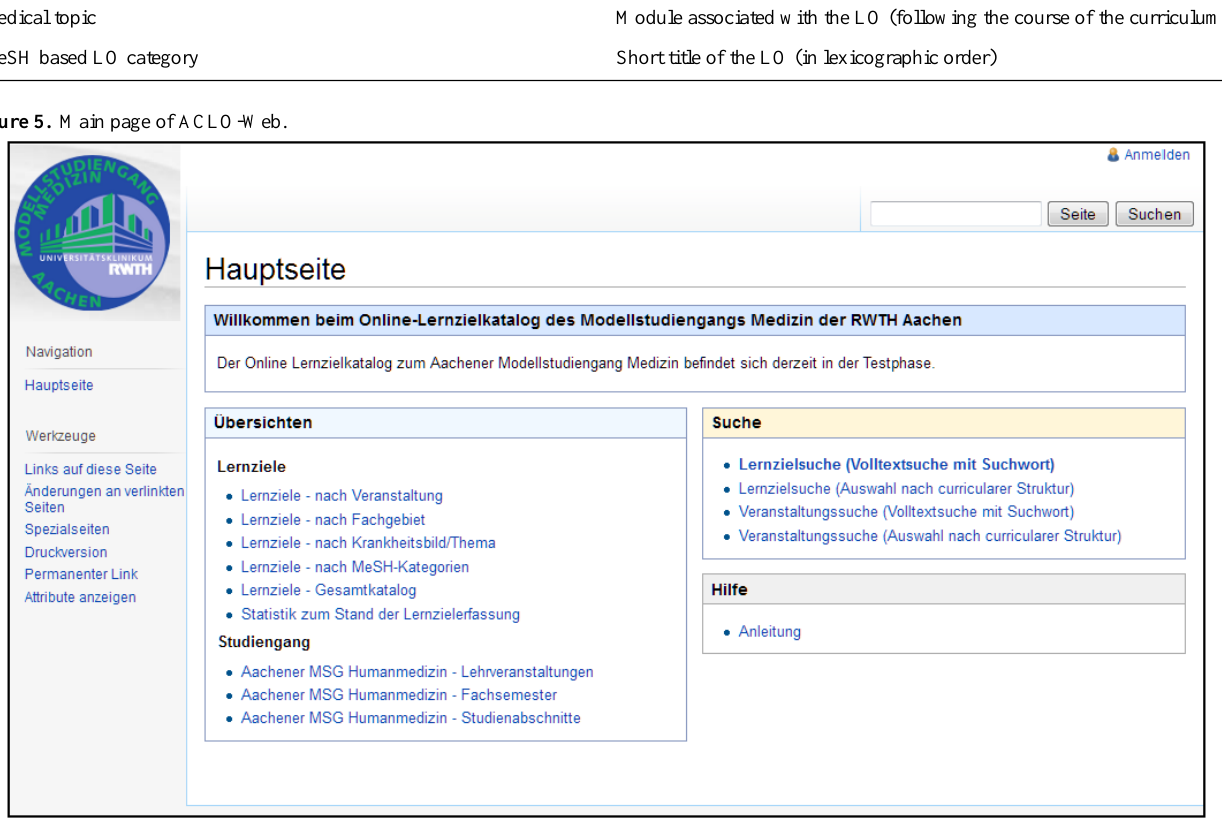
Sorting categoriesOverview of concerns